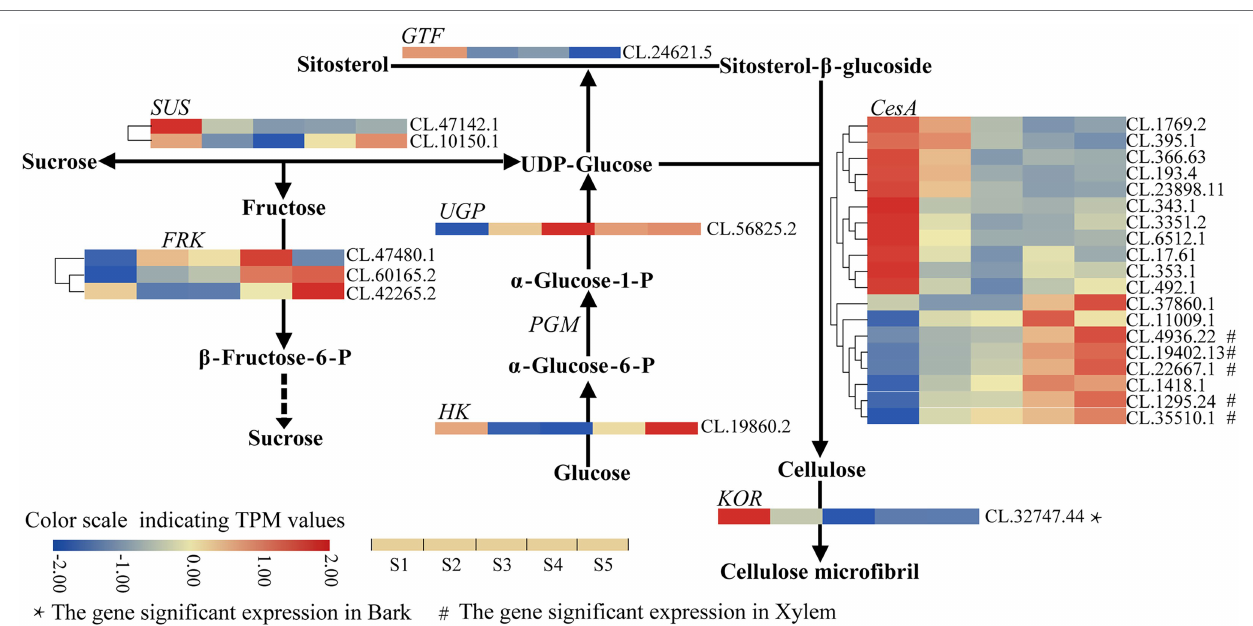
FIGURE 2 | Heatmap depicting the expression profiles of DEGs involved in cellulose biosynthesis in C. lanceolata